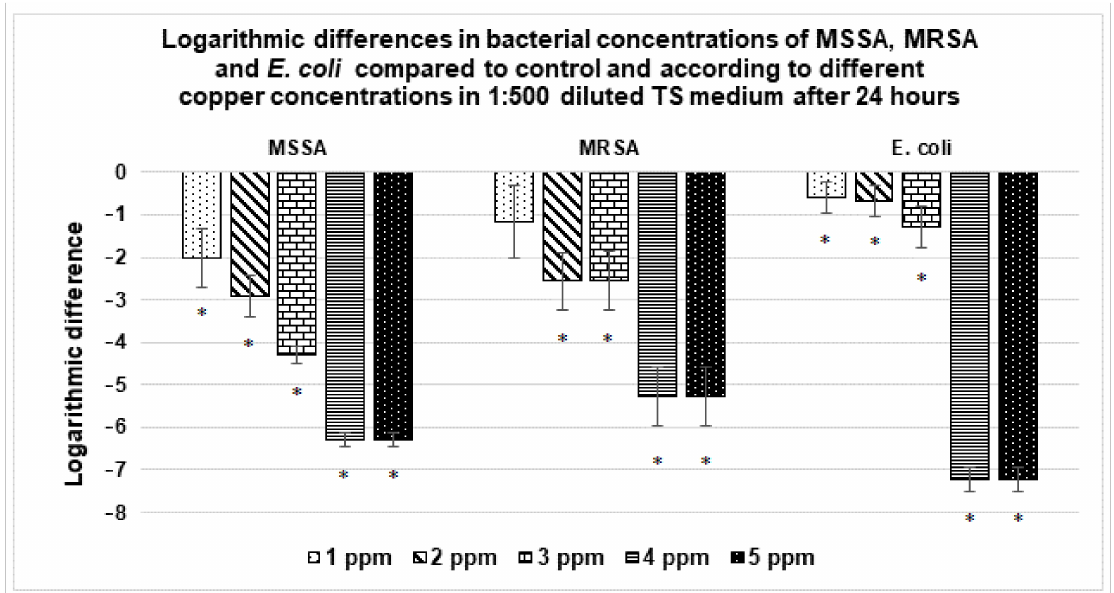
Figure 5. Variation in the bacterial concentration of MSSA, MRSA and E. coli with respect to different copper concentrations in 1:500 diluted TS medium after 24 h. Results statistically different compared to the control (with p < 0.05) are indicated by